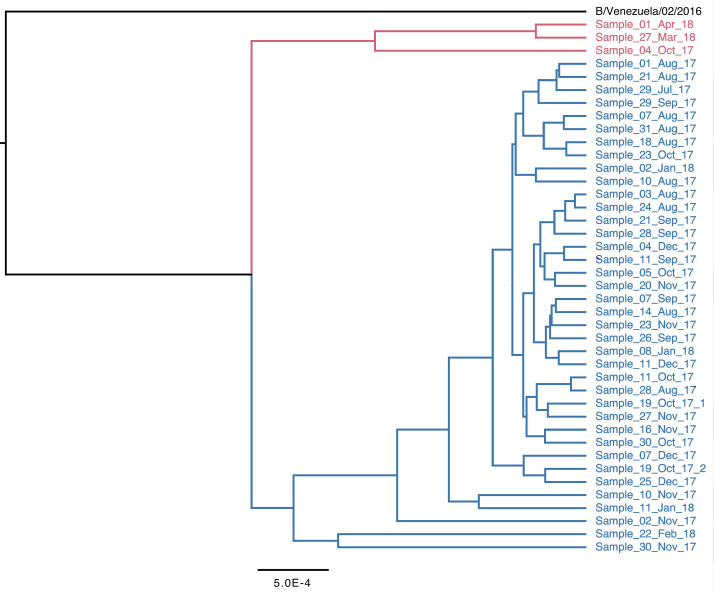
Complete phylogeny of whole-genome viral consensus sequences, coloured by clade.